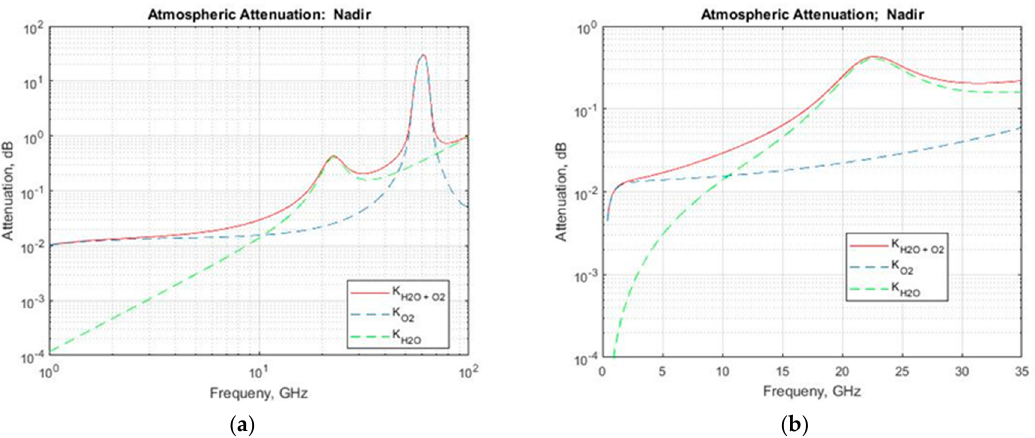
Figure A5. Specific attenuation at the surface for a standard atmosphere with Ts = 20 ◦ C and Figure C1. Specific attenuation at the surface for a standard atmosphere with Ts = 20 ℃ and RH20 = RH20 = 60%. Computations using the MPM92 model [37–39]. ( b ) is the same as ( a ) but with expanded 60%. Computations using the MPM92 model [37–39]. Figure C1 b is the same as Figure C1 a but with frequency expanded frequency scale.